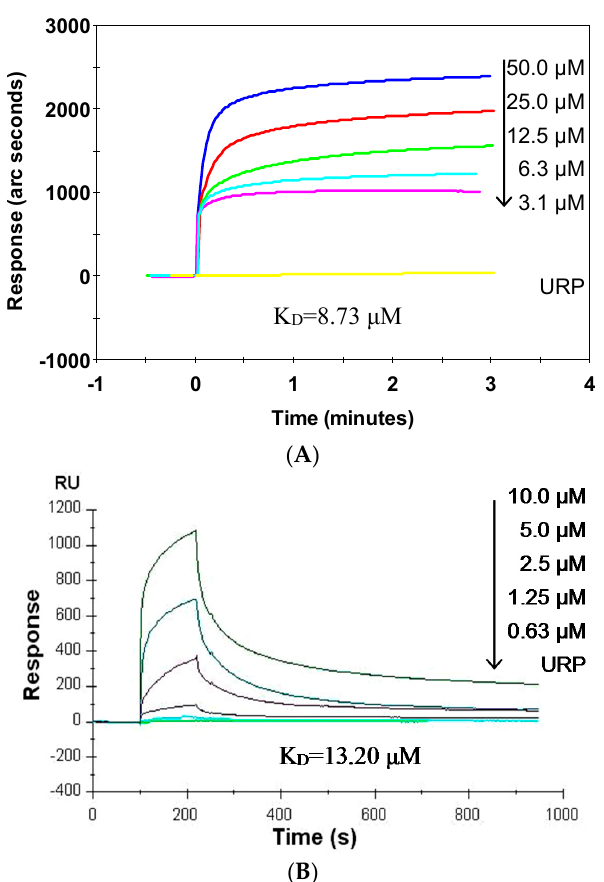
Figure 8. Synthetic peptide (SP) specifically binds ODN2006. ( A ) Binding curves generated by the IAsys biosensor. Biotinylated ODN2006 was immobilized on the surface of a streptavidin-coated cuvette. A series of concentration of SP (3.1, 6.3, 12.5, 25 or 50 μ M) or unrelated peptide (URP) (50 μ M) were added separately into the cuvette to generate the binding curves. Data were analyzed using FASTplot, and the dissociation equilibrium constant (K D ) of SP was calculated using FASTfit; ( B ) Binding curves generated by the Biacore biosensor. Biotinylated ODN2006 was immobilized on a streptavidin-coated chip, and then a series of concentrations of SP (0.63, 1.25, 2.5, 5 or 10 μ M) or URP (10 μ M) were loaded separately to generate the binding curves. Data analysis and K D calculation were performed using the BIAevaluation software.